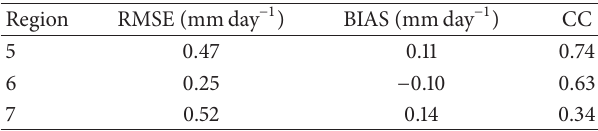
Table 3: Area averaged root mean square error (RMSE) and bias and spatial correlation coefficient (CC) for the annual mean pre- cipitation (mmday − 1 ) anomalies for HCSA strong cases over the last three regions of Figure 5 in the period